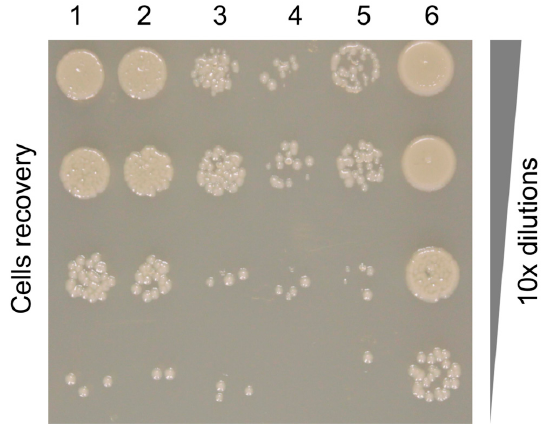
Figure 7. Pyocin fiber—pyocin competition assay. Recovery of viable P. aeruginosa 13s cells after pre-